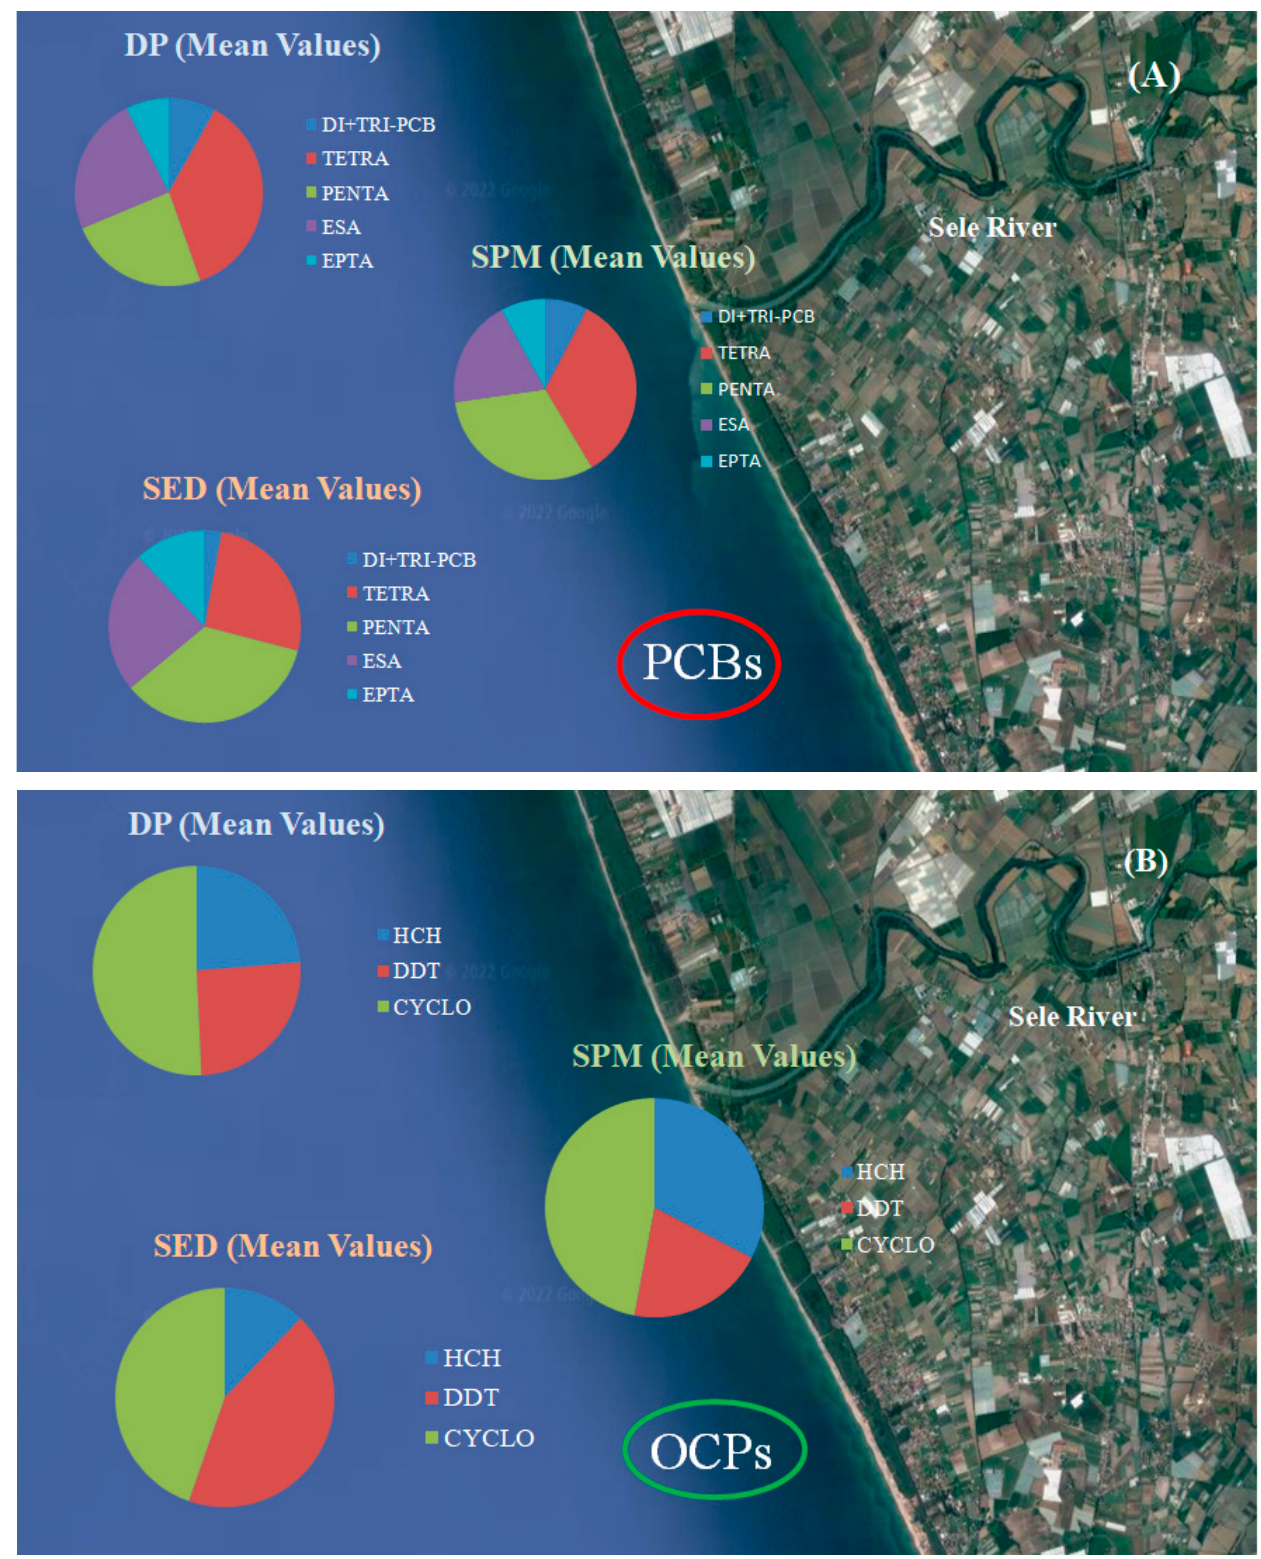
Figure 2. Mean concentrations of PCBs ( A ) and OCPs ( B ) in the water samples (DP), suspended particulate matter (SPM) and sediment (SED) from the Sele River, southern Italy.